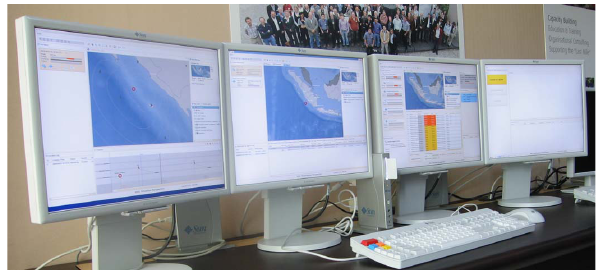
Fig. 3. The four screens (aka: Situation Perspective, Observation Perspective, Decision Perspective and Product/Dissemination Per- spective) on a training workplace in the Warning Centre of BMKG in